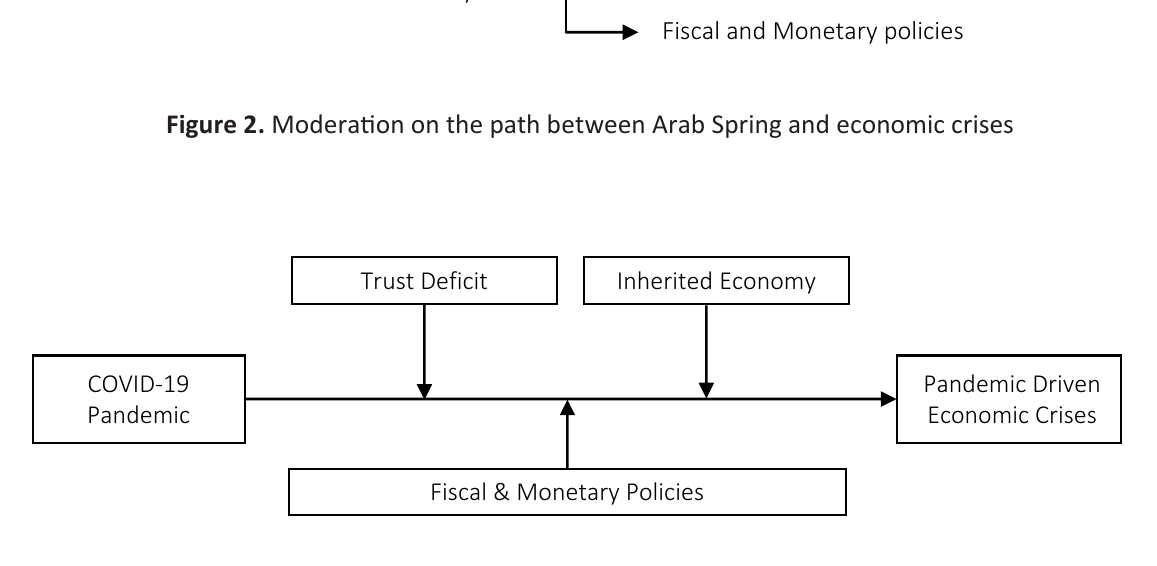
Figure 3. Theoretical framework (Moderation on the Path between COVID-19 and Economic